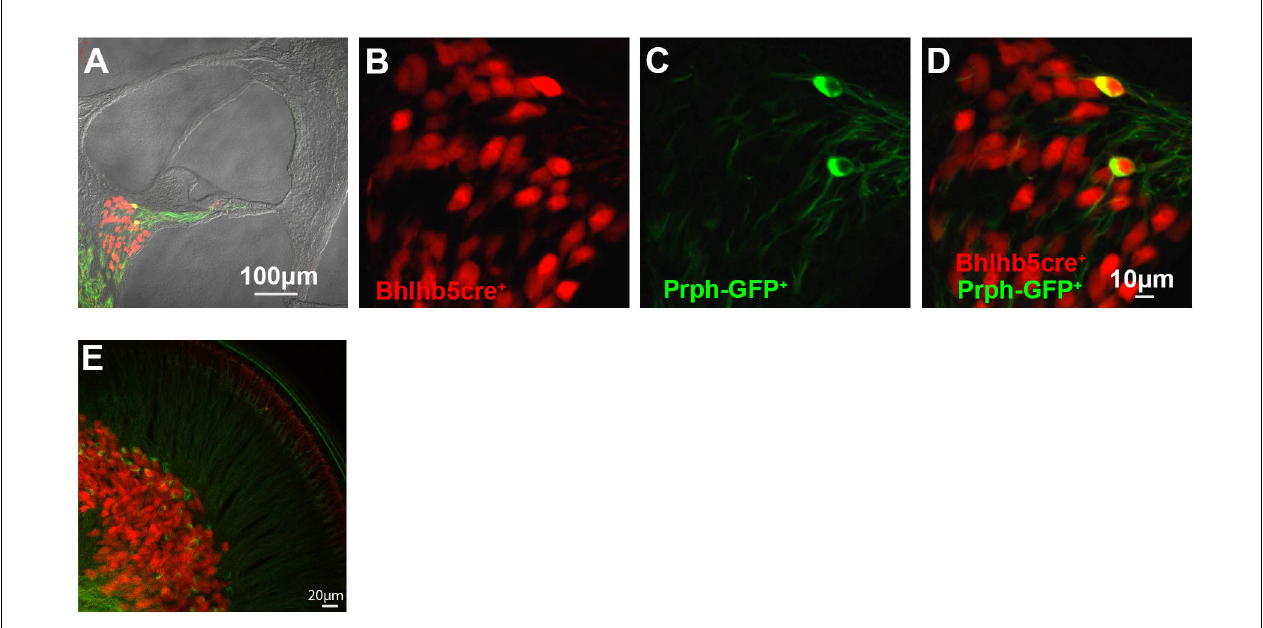
FIGURE 1 | Transgenic mouse model for spiral ganglion neuron (SGN) Type I and Type II Isolation. (A) Cross-section of the organ of Corti showing SGNs showing tdTomato; bhlhb5Cre (SGNIs) and Prph-GFP (SGNIIs) from cryopreserved tissue. (B,C) Fluorescent imaging of tdTomato and GFP. (D) Merge of panels (B,C) . (E) Whole-mount of the organ of Corti showing cell body and projections of SGN type I (red) and type II (green) from cryopreserved tissues. All images are representative fields from experiments repeated three times ( n =